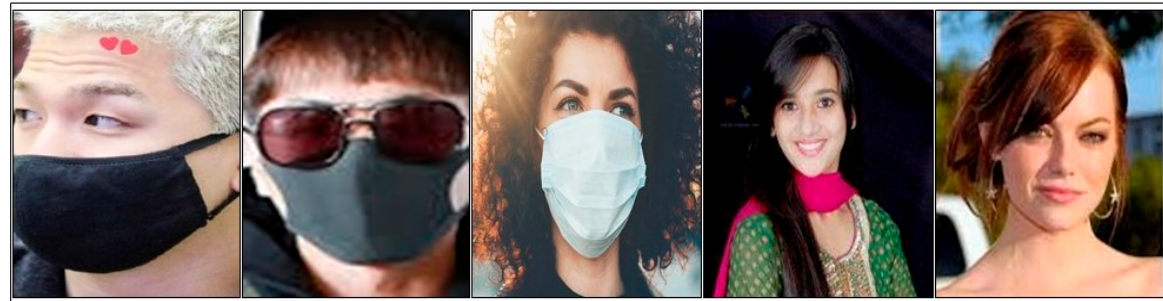
Figure 3. Sample images used for neural network training.